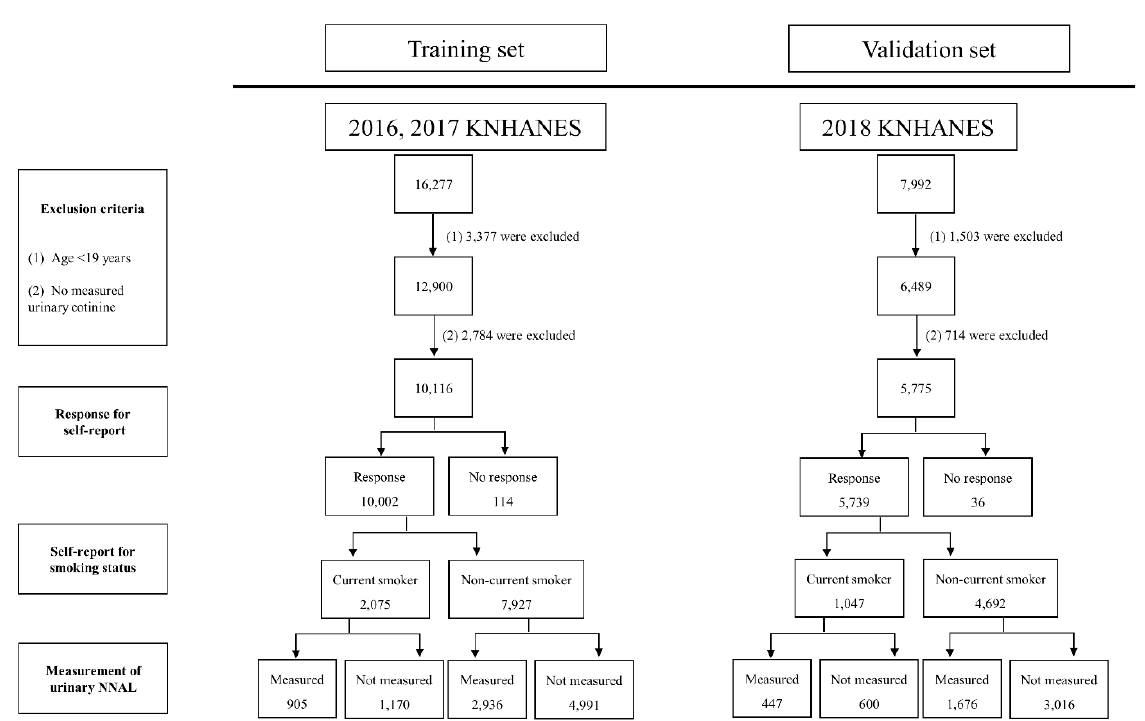
Figure 1. Schematic flow chart of the study design and exclusion criteria.